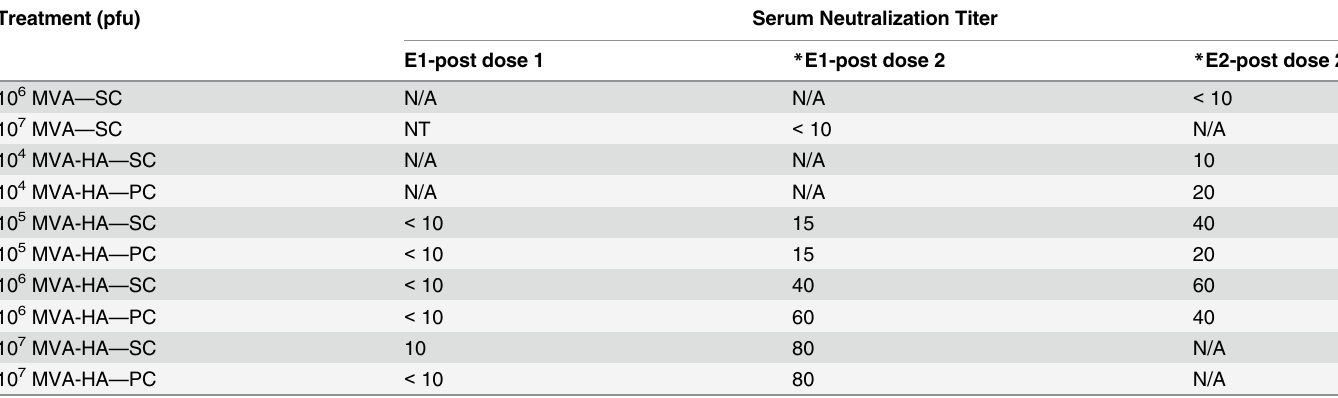
NT = Not tested; N/A = not applicable; E1-post dose 1 = experiment 1,post prime antisera; E1-post dose 2 = experiment 1, post boost antisera; E2-post dose 2 = experiment 2 post boost antisera; * titer represents the average of two repeat testing. For each treatment group, serum samples (5 per group) were pooled for neutralization test.